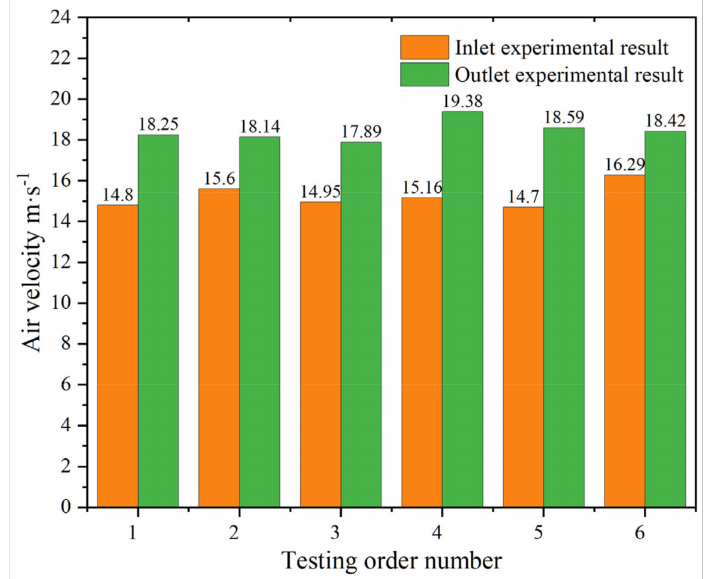
Figure 9. Outlet and inlet wind speed test measurement